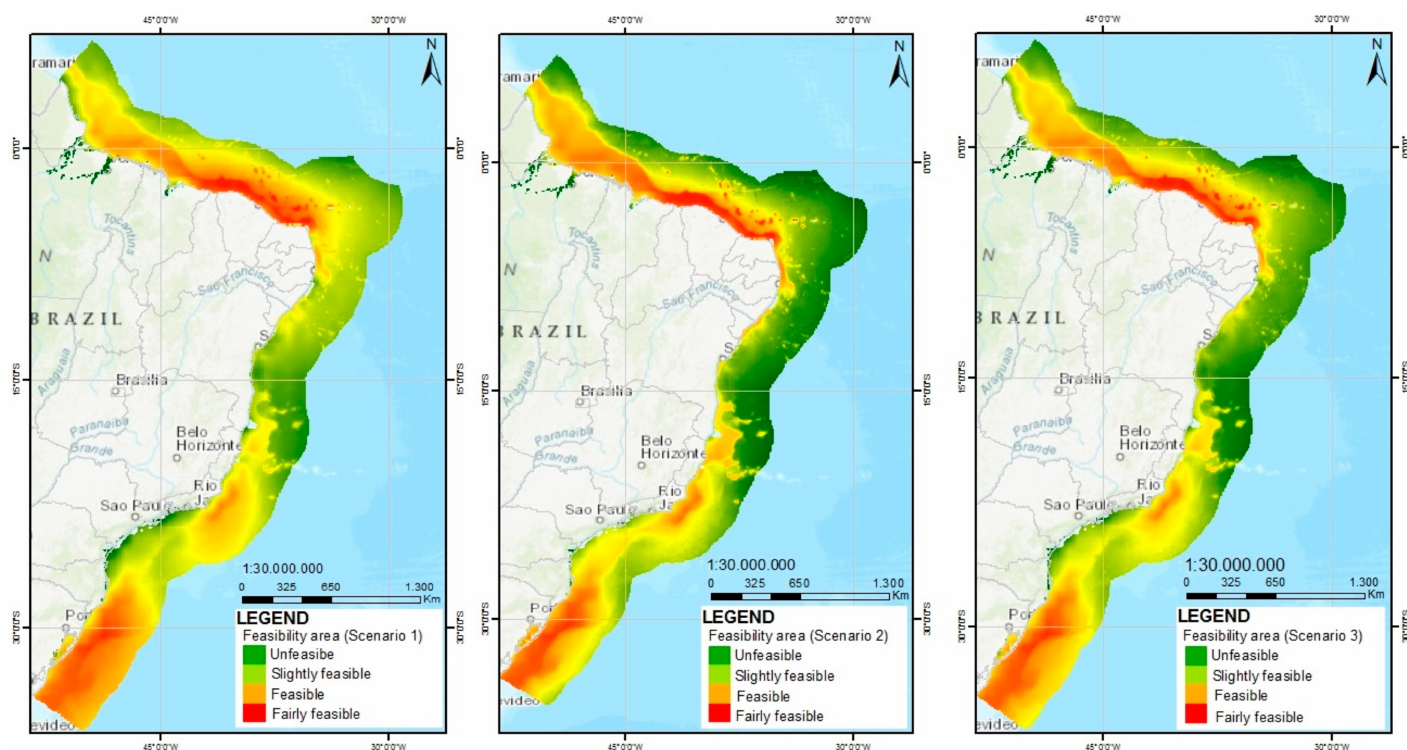
Figure 9. Scenarios produced by applying the feasibility